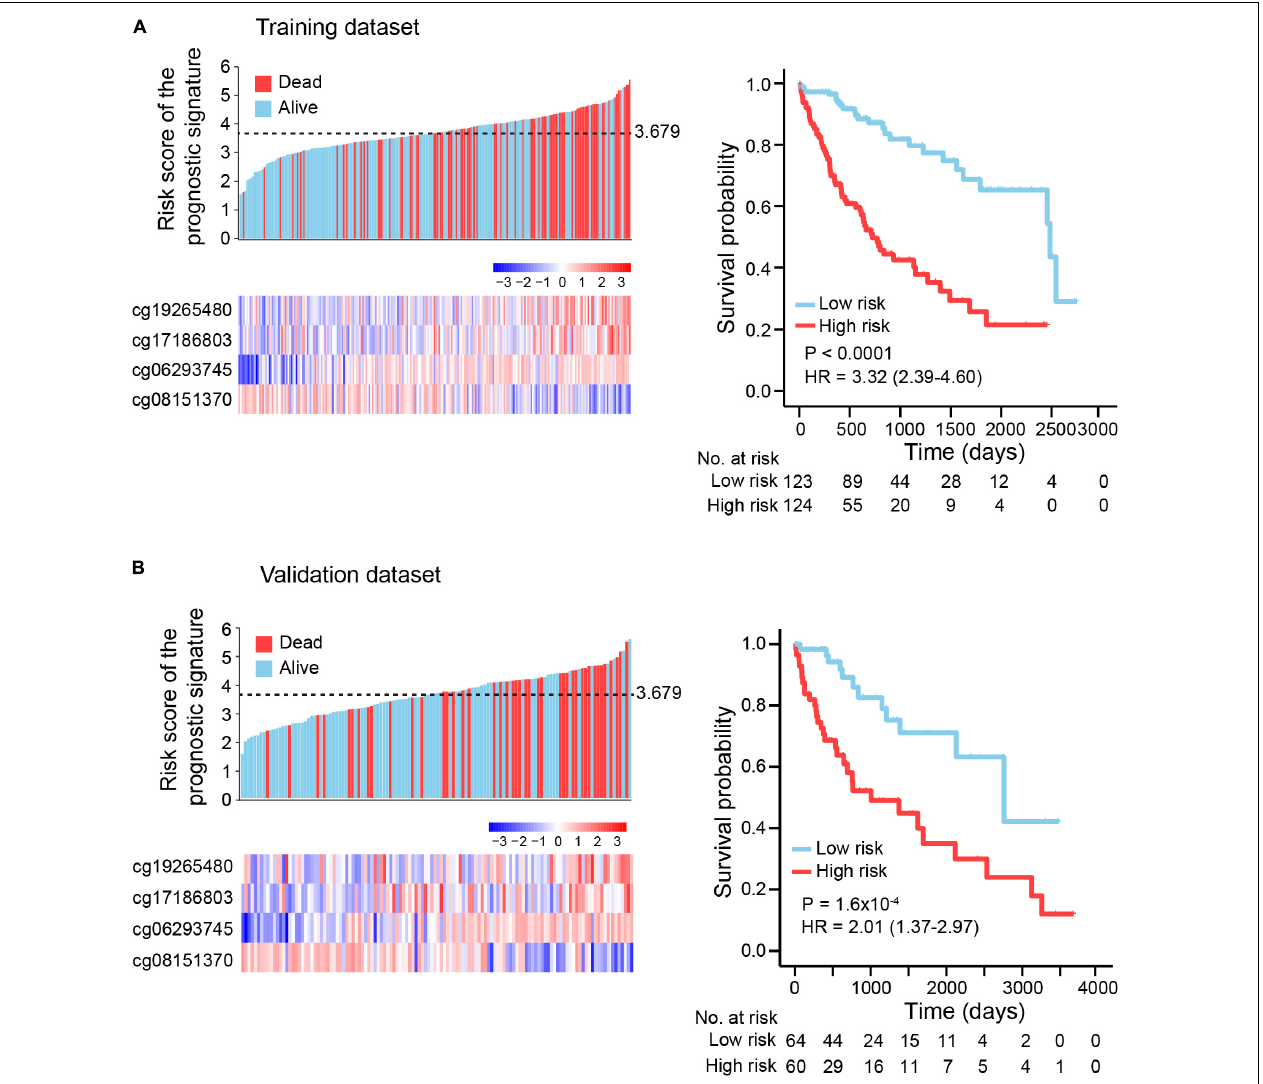
FIGURE 3 | Kaplan-Meier (KM) survival analysis based on the risk score of the prognostic signature. (A) Training dataset (two-thirds of TCGA dataset), (B) Validation dataset (one-third of TCGA dataset). Upper left panel: the distribution of risk scores and survival status of HCC patients; lower left panel: heatmap showing methylation level of four DNA methylation markers in HCC patients. Right panel: HCC patients were divided into low-risk and high-risk groups using a median cutoff value (black dotted line: 3.679, upper left panel) of risk scores. KM curves along with log-rank test and hazard ratio (HR) were used to compare and visualize the OS of low-risk and high-risk